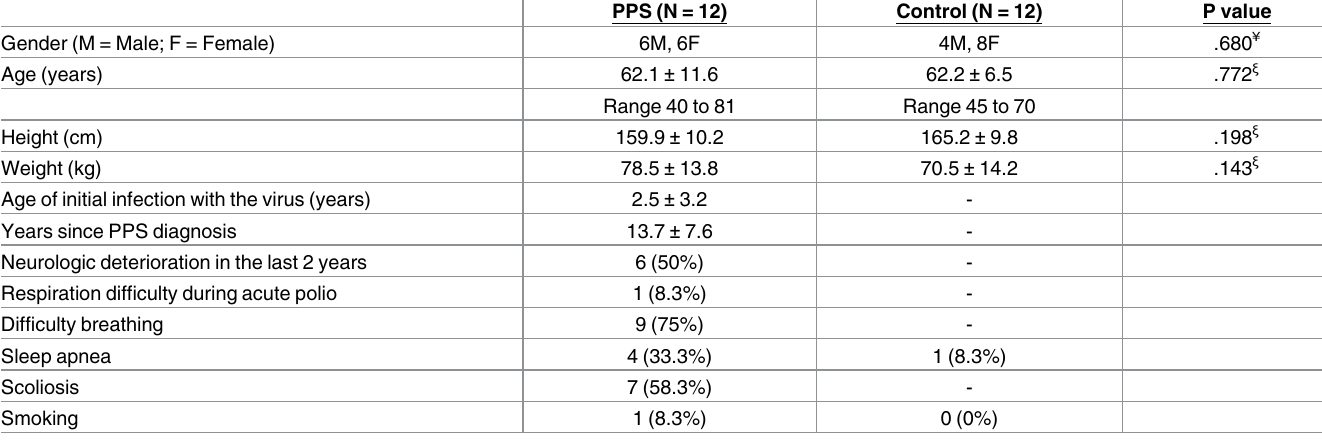
Table 1. Personal characteristics of the Post Polio Syndrome (PPS) group and the control group. Numeric values are presentedas mean ± standard deviation. Other data are presentedas the number of subjects(percent of each group; N =